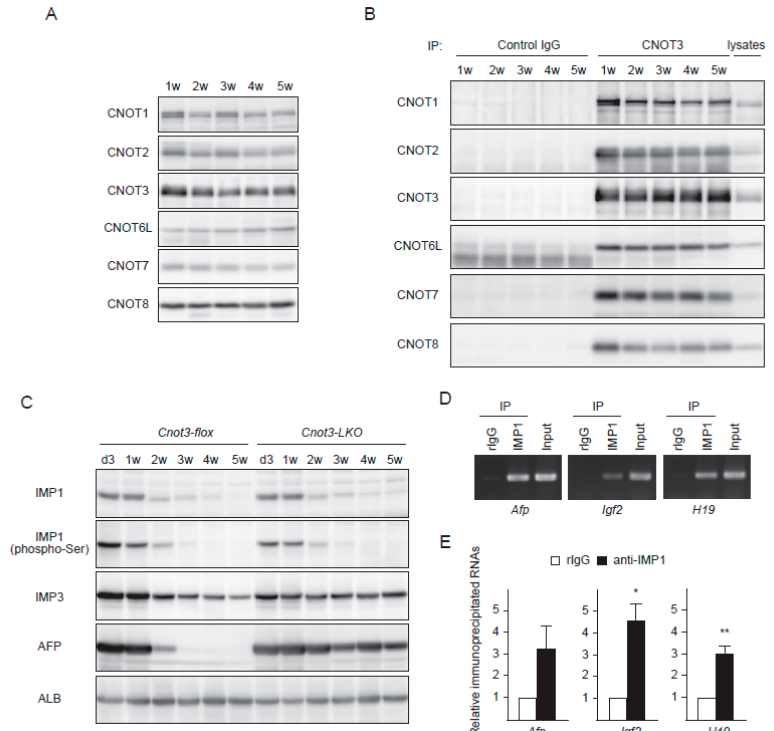
Figure 2. IMP1 abundance, but not that of the CCR4-NOT complex decreases as liver matures. ( A , B ) Immunoblot of mouse liver lysates ( A ) and anti-CNOT3 immunoprecipitates from mouse liver lysates ( B ) at the indicated postnatal days. Antibodies used are indicated on the left. ( C ) Immunoblot of liver lysates from control and Cnot3-LKO mice at the indicated postnatal days. Antibodies used are indicated on the left. ( D , E ) Liver lysates from 2 w mice were immunoprecipitated with control rabbit immunoglobulin (rIgG) or antibodies against IMP1. RNAs in immunoprecipitates were analyzed by RT-PCR (D) or qPCR ( n = 3) (E) for the indicated genes. Values in graphs represent means ± sem. * p < 0.05, ** p < 0.01.